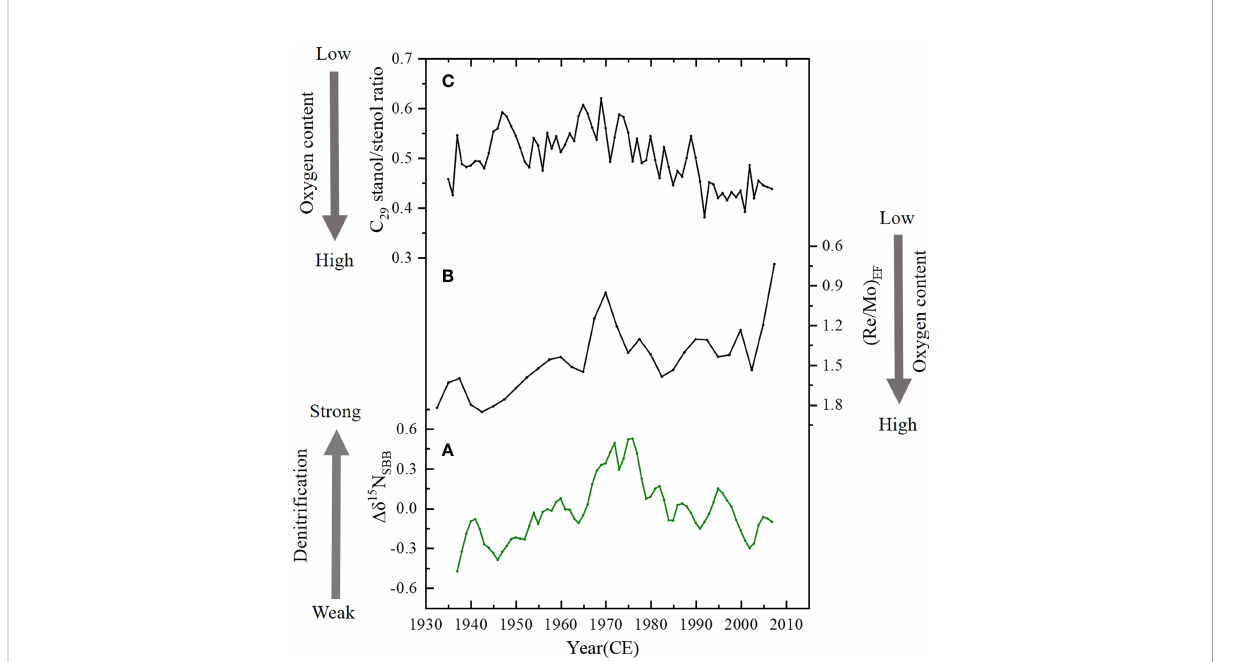
FIGURE 7 Comparisons of the (A) Dd 15 N SBB with redox proxies: (B) (Re/Mo) EF record (Wang et al., 2017) and (C) C 29 stanol/stenol ratio record (Alfken et al., 2021). Note that the scale of (Re/Mo) EF record is